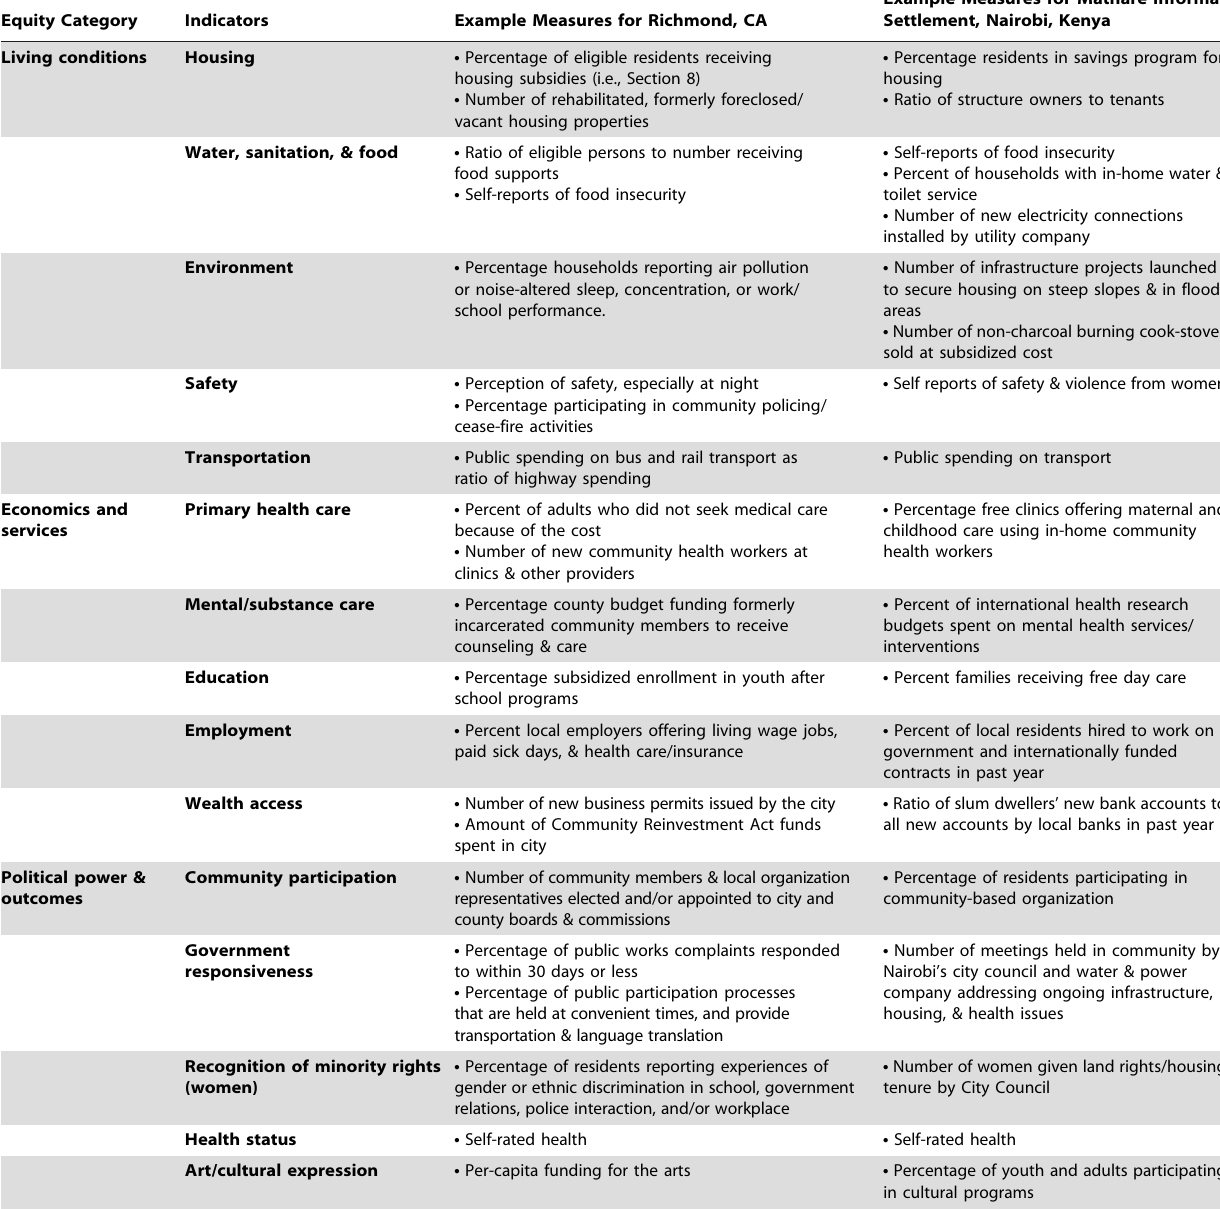
Table 2. Examples of urban health equity